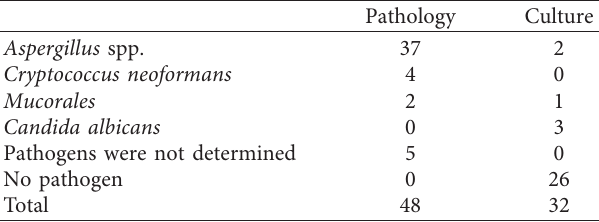
Table 1: Spectrum of pathogens causing invasive pulmonary fungal disease diagnosed by